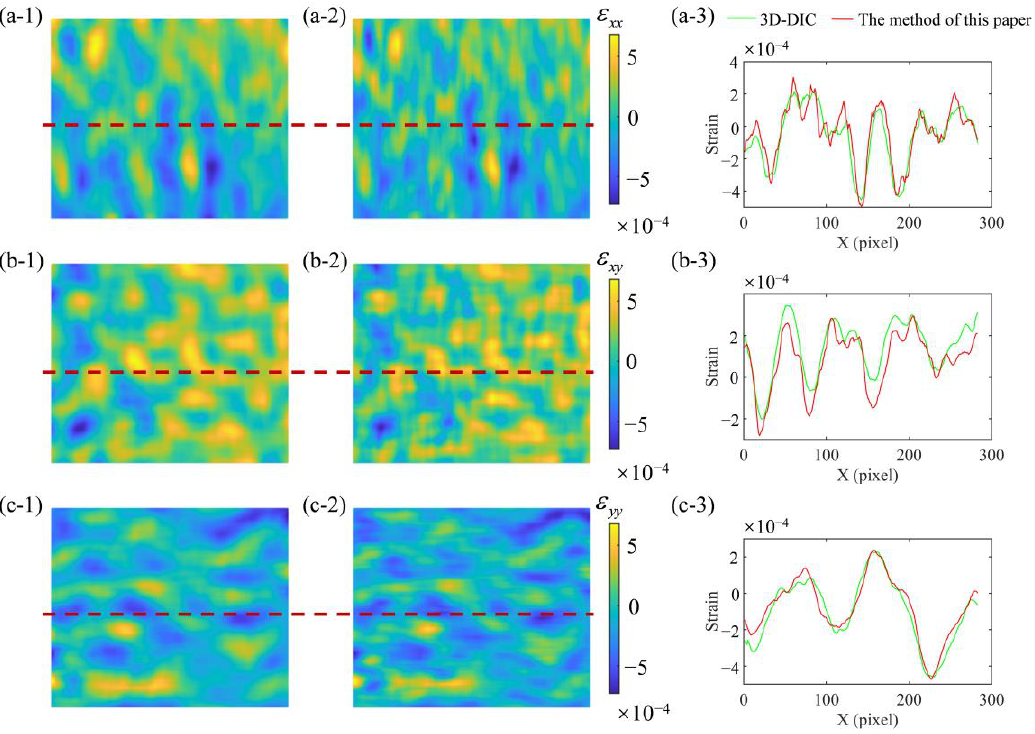
Figure 11. The distribution of full-field strain. ( a1 , b1 , c1 ) the full-field strain distributions calculated using 3D-DIC; ( a2 , b2 , c2 ) the full-field strain distributions calculated using the method of this paper; ( a3 , b3 , c3 ) the strain solved using two methods at the red dotted line.